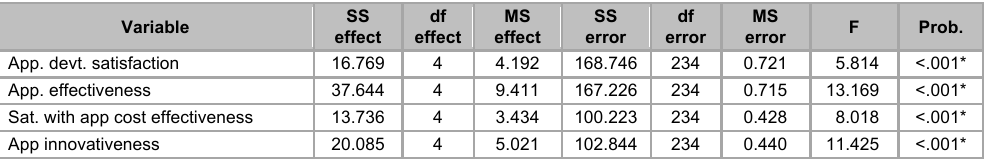
Analysis of variance: Development